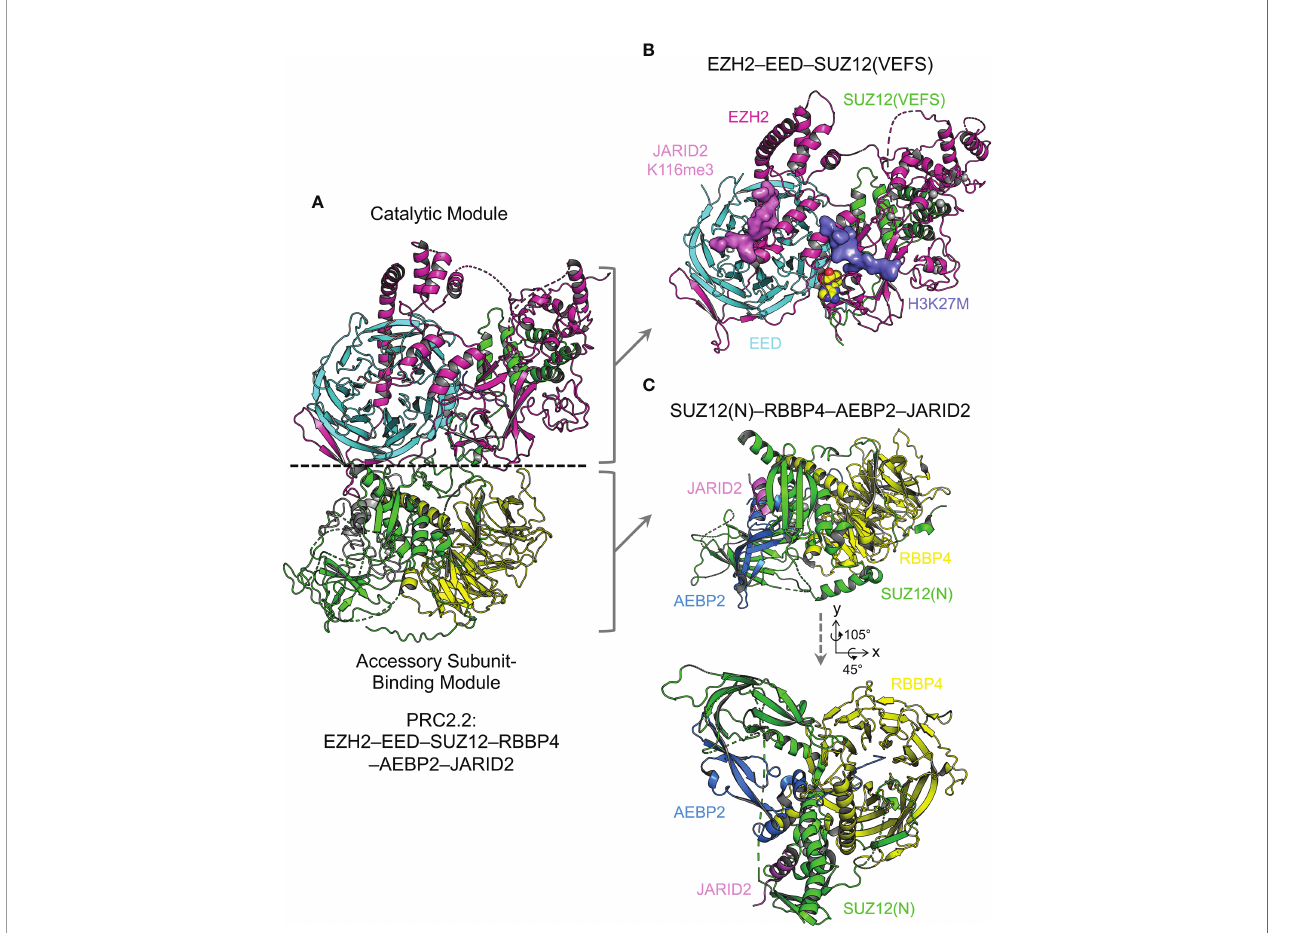
FIGURE 3 | Overall structure of PRC2.2 The overall structure of PRC2 is revealed by X-ray crystallographic and cryo-EM studies. The PRC2 core complex can be structurally divided into two modules. Components of structures are color-coded. Structure fi gures are rendered in PyMOL (The PyMOL Molecular Graphics System, Version 2.5.2 Schrödinger, LLC). (A) Cryo-EM structure of AEBP2 and JARID2-bound PRC2.2 (PDB 6C23). (B) Crystal structure of the catalytic module of PRC2 (PDB 5HYN). H3K27M and JARID2K116me3 peptides are shown as surface representation. (C) Crystal structure of the accessory subunit-binding module bound to AEBP2 and JARID2 (PDB 5WAI). Two views are shown with the rotation matrix